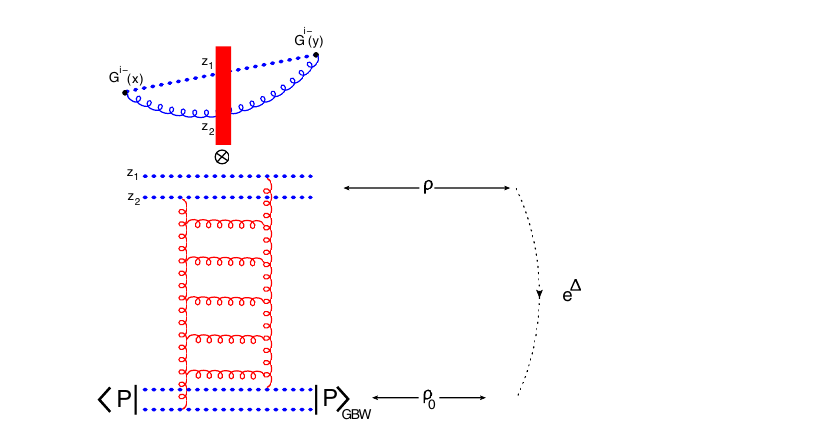
Figure 1. Diagrammatic representation of the HE-OPE applied to the gluon non-local operator with “quasi-PDF